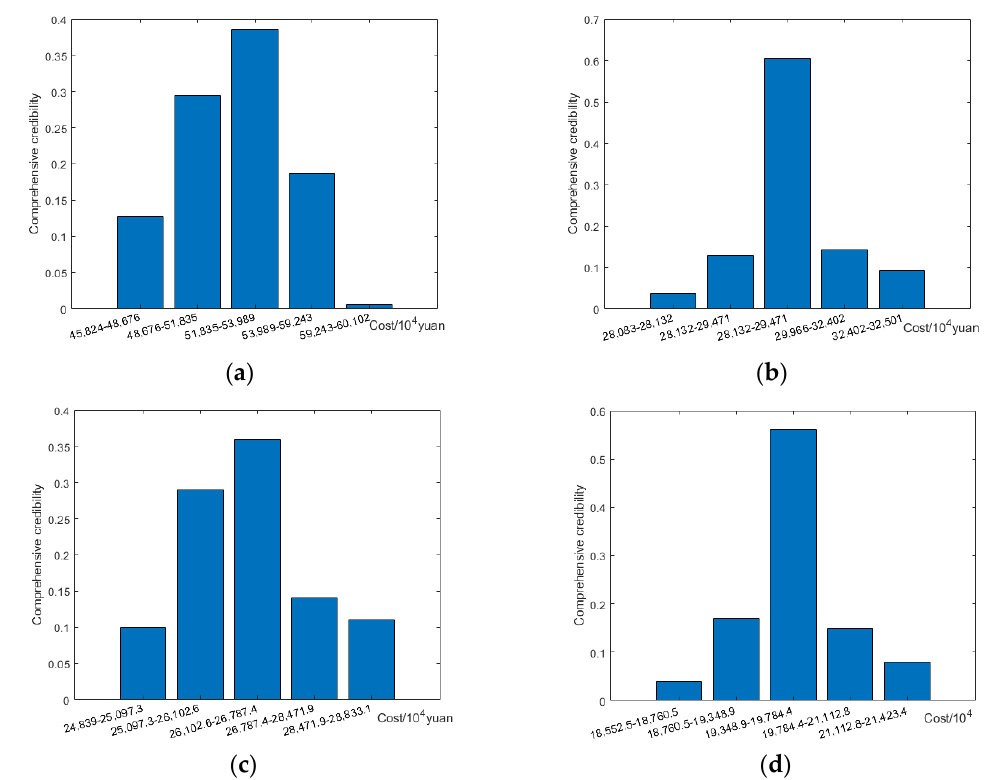
Figure 4. Life ‐ cycle cost of NESC and the SCTTU with different service life: ( a ) NESC (30 year service life); ( b ) SCTTU (20 year service life); ( c ) SCTTU (15 year service life); ( d ) SCTTU (10 year service life).